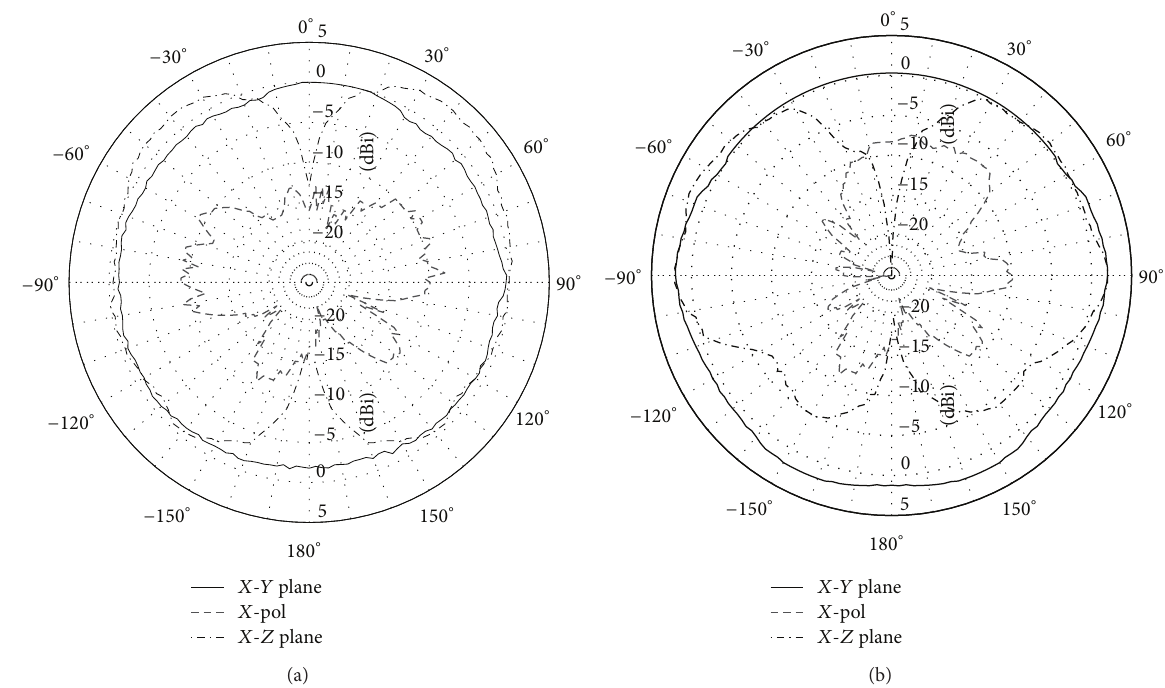
Figure 14: Measured radiation pattern of (a) reduced IFA and (b) reduced